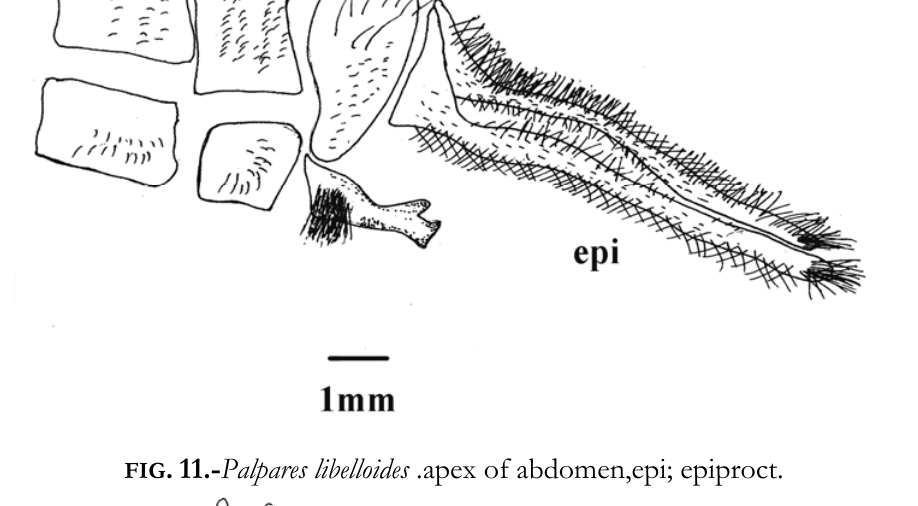
FIG . 11.- Palpares libelloides .apex of abdomen,epi; epiproct.